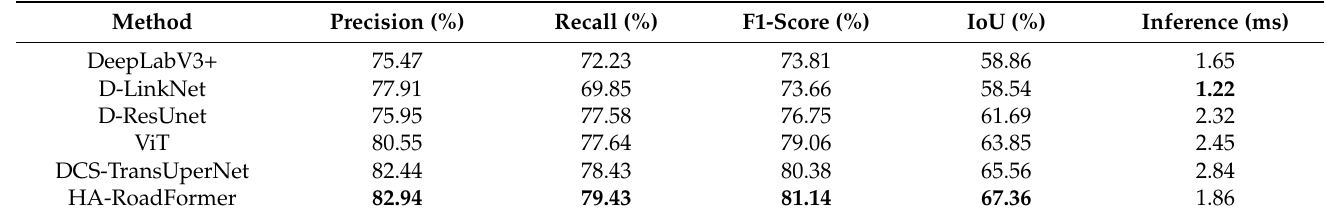
Table 1. Quantitative analysis results with different methods on the Massachusetts roads dataset.